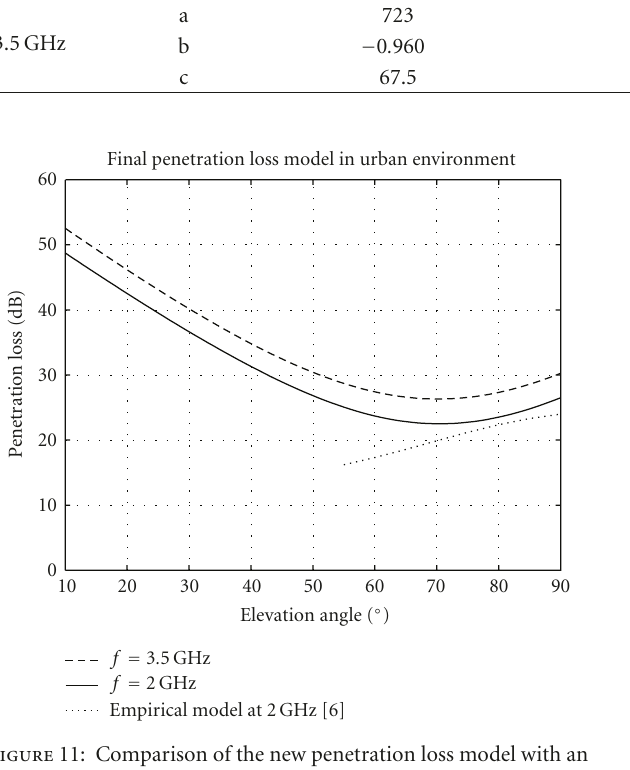
Figure 11: Comparison of the new penetration loss model with an empirical model developed for high elevation angles in